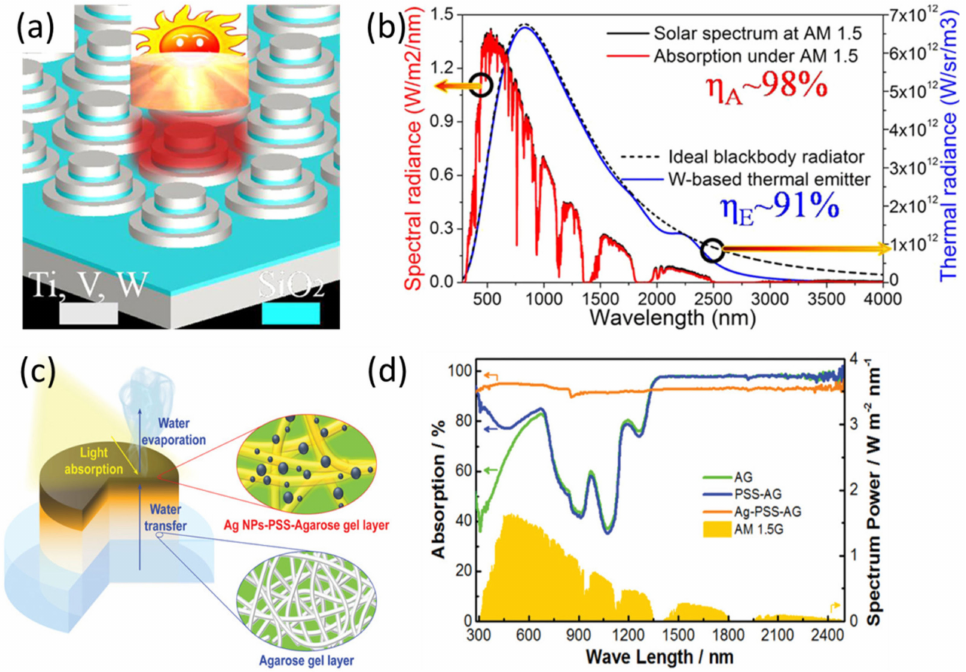
Figure 3. Preparation and application of thin-film solar thermophotovoltaics. ( a ) Schematic diagram of the Ti-based solar absorber. ( b ) Direct comparison between the standard spectrum of solar radiance under an air mass (AM) of 1.5 (solid line) and the solar energy absorption of the solar absorber under an AM of 1.5 (dotted line). Absorption e ffi ciency of the solar absorber (dashed line). Reproduced with permission from [39]. Copyright Elsevier, 2019. ( c ) Schematic illustration of the double-layer solar vapor generation device. The top silver-poly (sodium-p-styrenesulfonate)-agarose gel (A-gPSS-AG) layer serves as the light-harvesting module, while the bottom AG layer acts as the water-transfer module. ( d ) UV–vis-NIR absorption spectra of AG, PSS-AG, and Ag-PSS-AG samples. Reproduced with permission from [41]. Copyright Wiley,